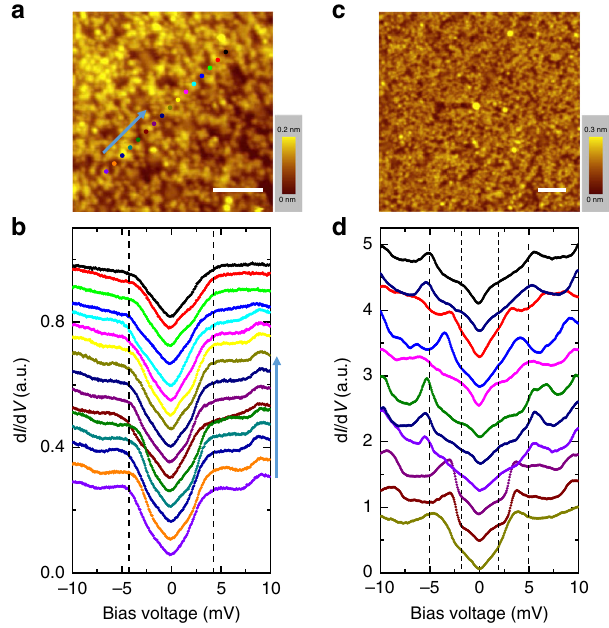
Fig. 4 Tunneling spectra measured on the smoother surface.